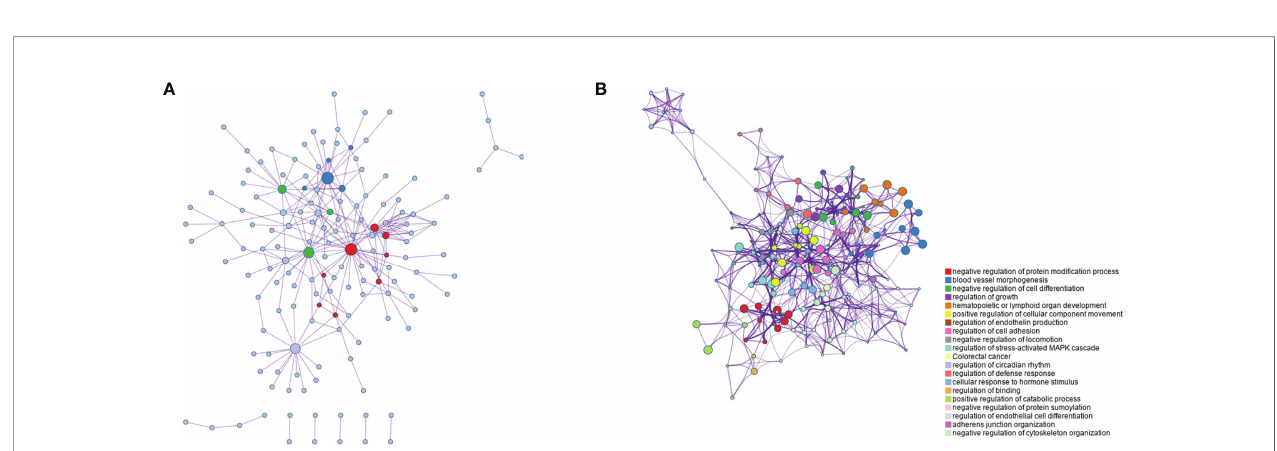
FIGURE 3 | Function clustering analysis of genes in key modules. (A) Co-expression network diagram of 280 key genes; (B) Rich term network of genes, showing the top 20 functional